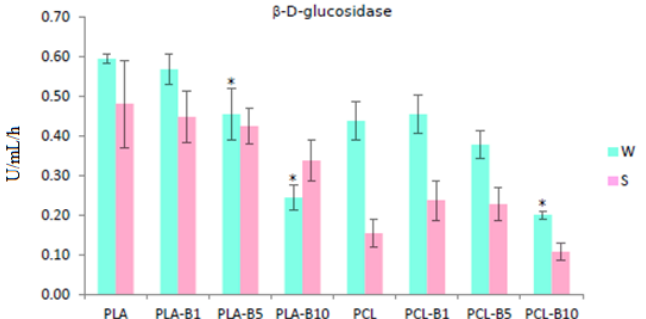
Figure 6. The enzymatic activity (lipase, aminopeptidase, esterase, α -D-glucosidase, and β -D-glucosidase) of biofilm-forming microorganisms on PLA, PCL, and films with birch tar, in river water and soil (* statistical differences). The data shows that the activity of lipase, aminopeptidase, esterase, α -D-glucosidase, and β -D-glucosidase was affected by the birch tar concentration, and by the environment in which the films were deposited (Figure 6). All the enzymes showed a decrease in activity with an increase of the biocidal compound concentration. This decrease was linear except for β -D-glucosidase activity in the soil (Table 1). Mann–Whitney test for equal medians for enzyme activities in different materials and environments is presented in Table 2. Table 1. Least square linear regression analyses of tar concentration and enzyme activities.